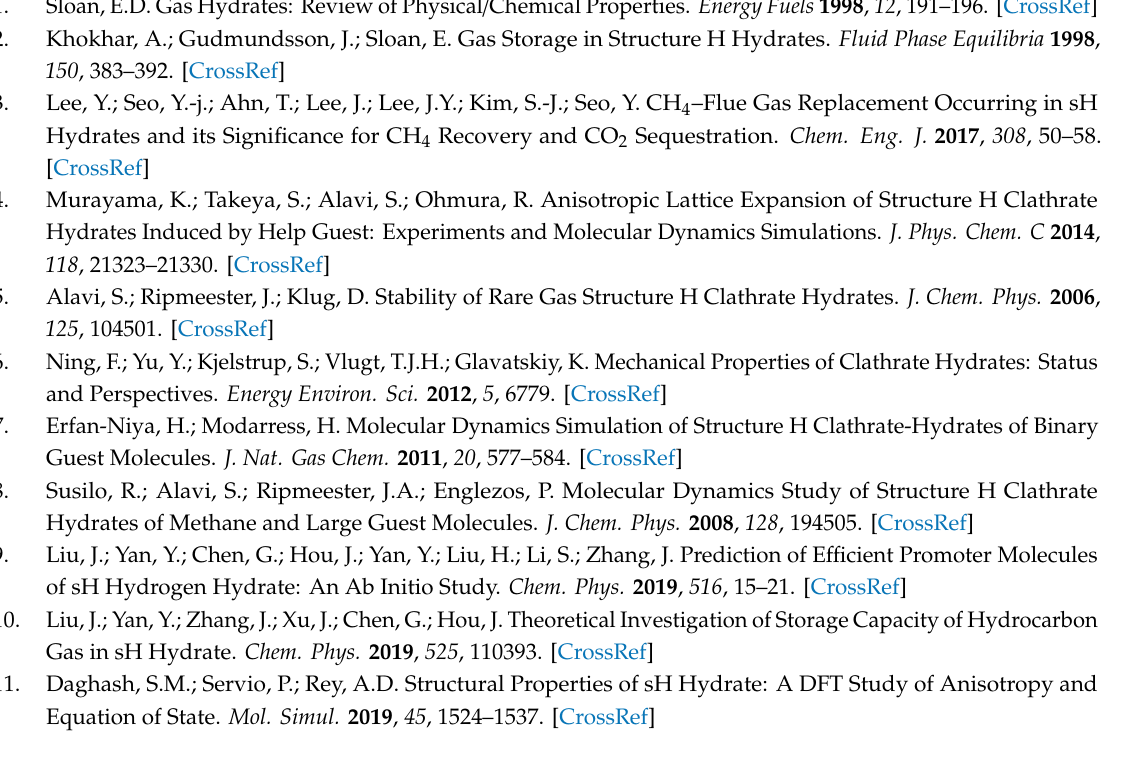
Supplementary Materials: The following are available online, schematics of sH gas hydrate water molecules’ main vibrational modes as well as some guest vibrations are available with average frequency